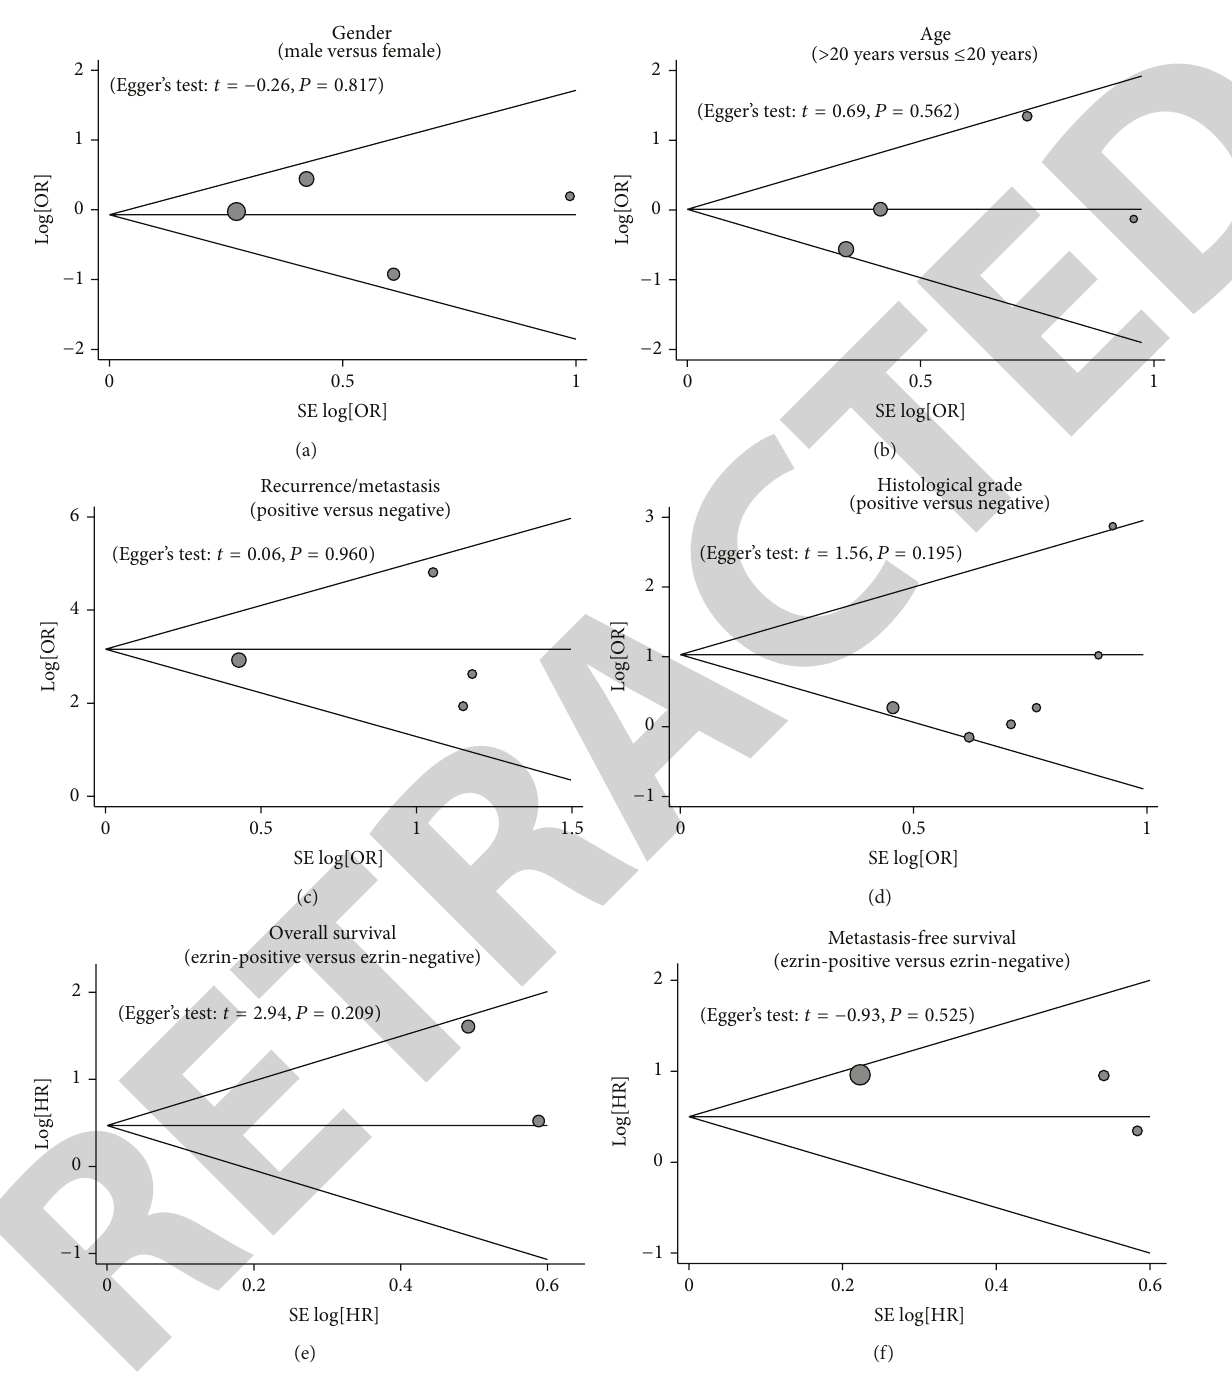
Figure 5: Funnel plot of publication biases for the correlations of ezrin expression with pathological characteristics and prognosis of osteosarcoma: a